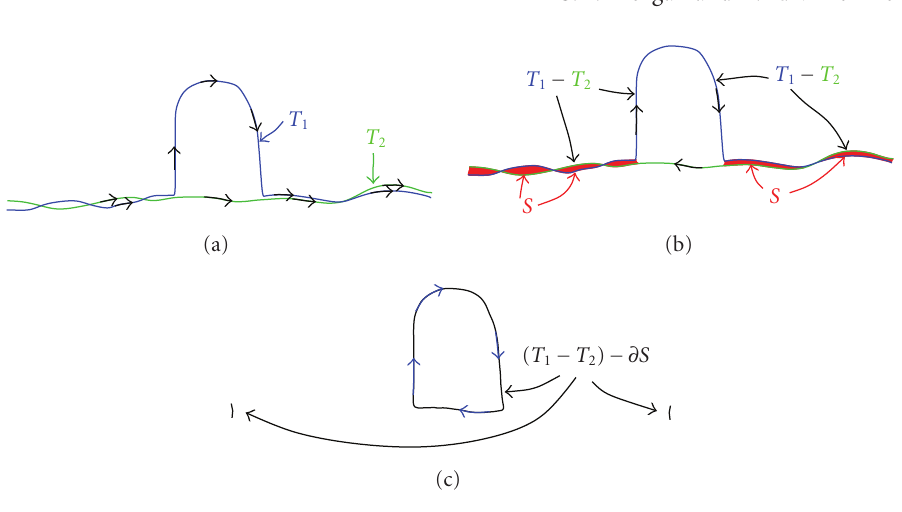
Figure A.4. The flat norm of the di ff erence between these two currents is the sum of the area of red region ( L 1 like) and the length of the loop that is